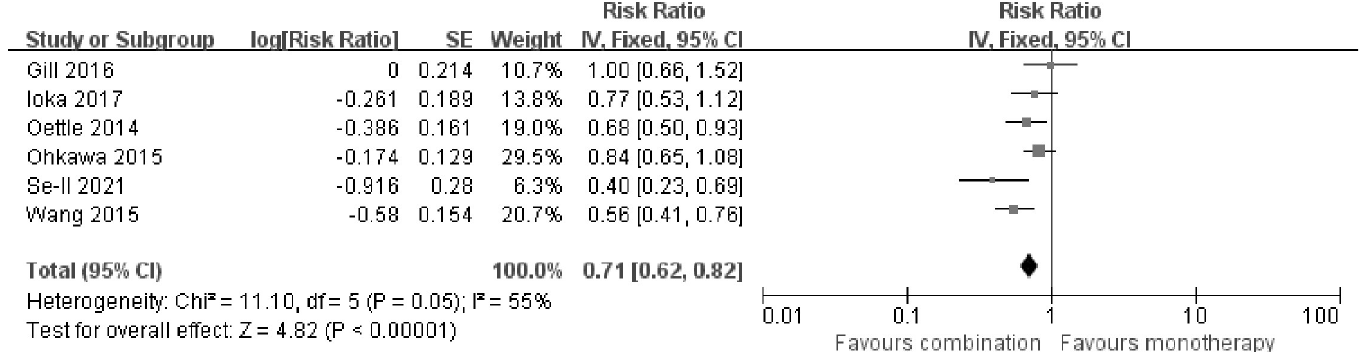
Fig 3. Comparison of PFS between fluoropyrimidine combination therapy and fluoropyrimidine monotherapy. SE: Standard error. CI: Confidence interval. IV: Inverse variance. Diamonds represented the 95% confidence interval of overall effect.